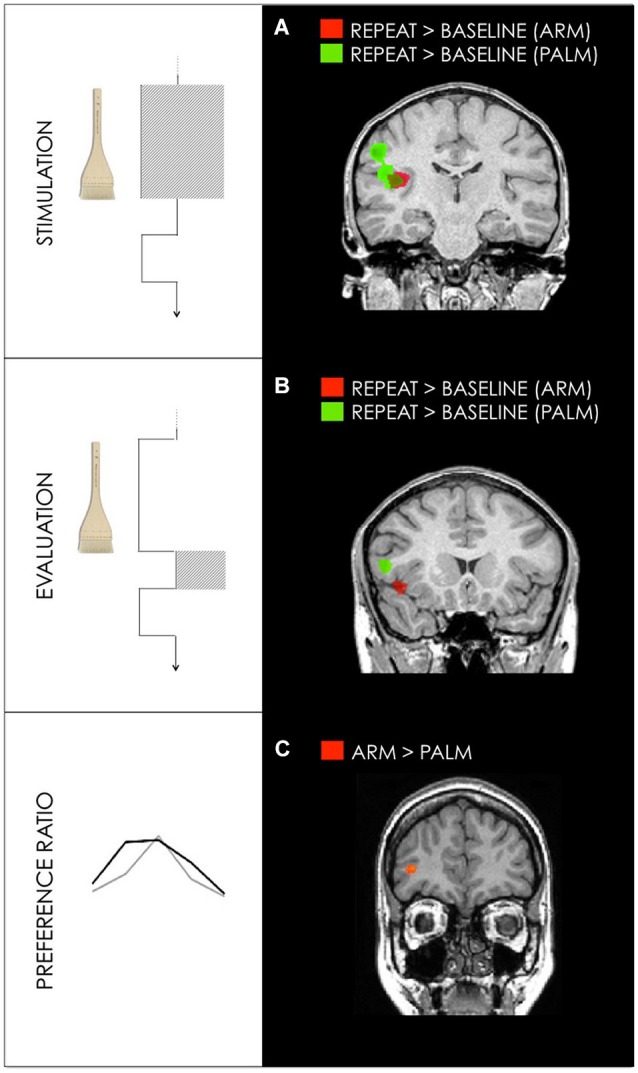
(A) Activation maps for GLM1: Stimulation Differences between hedonic stroking vs. fixation for arm (red) and palm (green) during stimulation interval. (B) Activation maps for GLM2: Evaluation. Differences between hedonic stroking vs. fixation for arm (red) and palm (green) during the evaluation interval. (C) Activation maps for GLM3: Preference ration. Differences between arm and palm for the GLM3 revealed activation in right dlPFC (35, 40, 3). Random effect contrasts were performed at a corrected threshold of p < 0.001. Talairach coordinates, radiological convention (left is right).